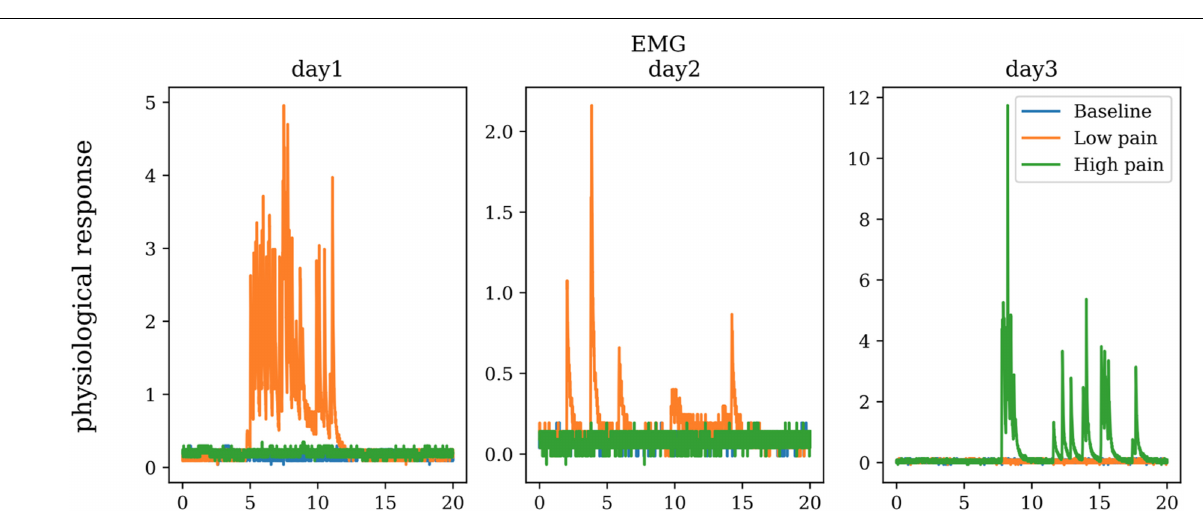
FIGURE 9 | The electromyography (EMG) of one subject on three repeated